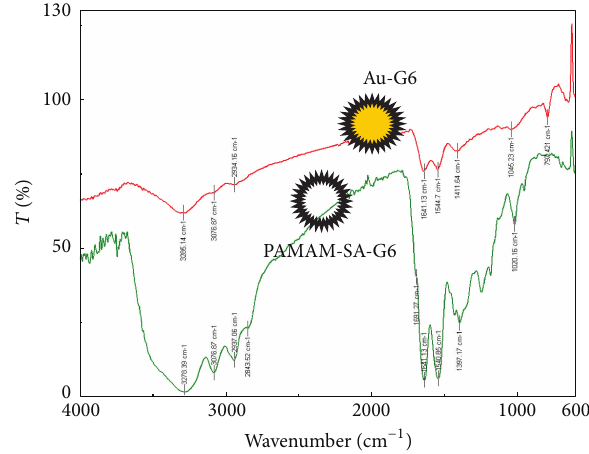
Figure 4: FTIR spectra of gold nanocomposites formed using PAMAM-SA-G6 dendrimers; spectra recorded after extensive rins- ing with ddw. PAMAM-SA-G6 was used as